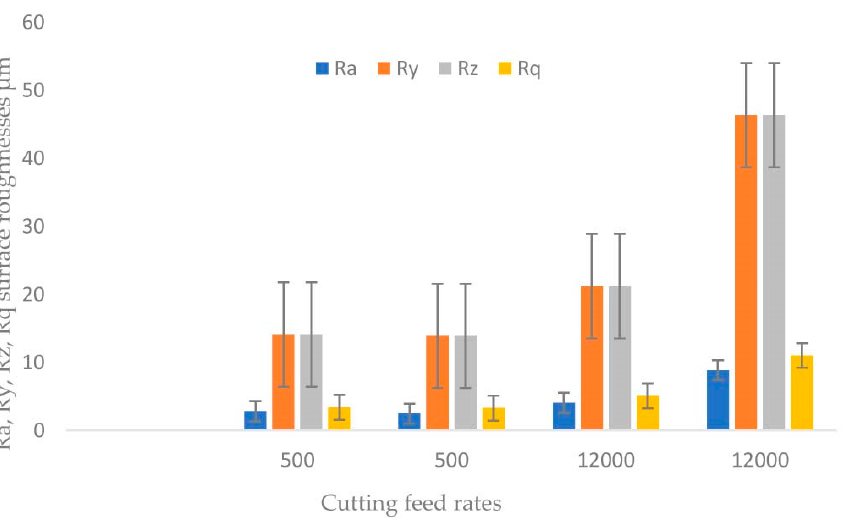
Figure 15. Surface roughness measurements at Points 1 and 2 on the cutting surface edge at 500 and 12,000 mm/min and 30 A.